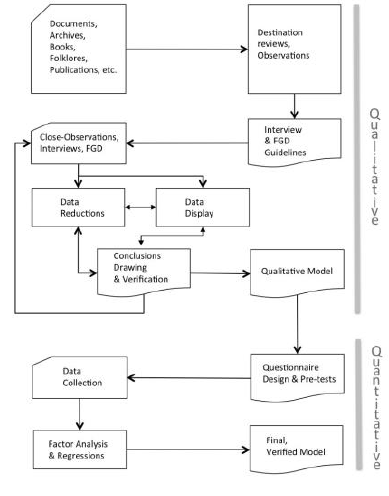
Figure 2. Overall research